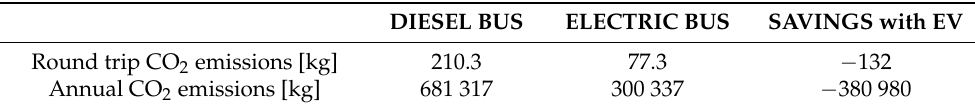
Table 7. Emissions comparison (Diesel vs.